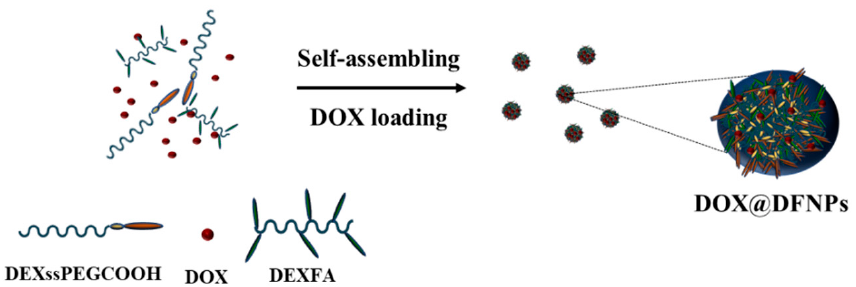
Figure 6. Schematization of DOX loading procedure.